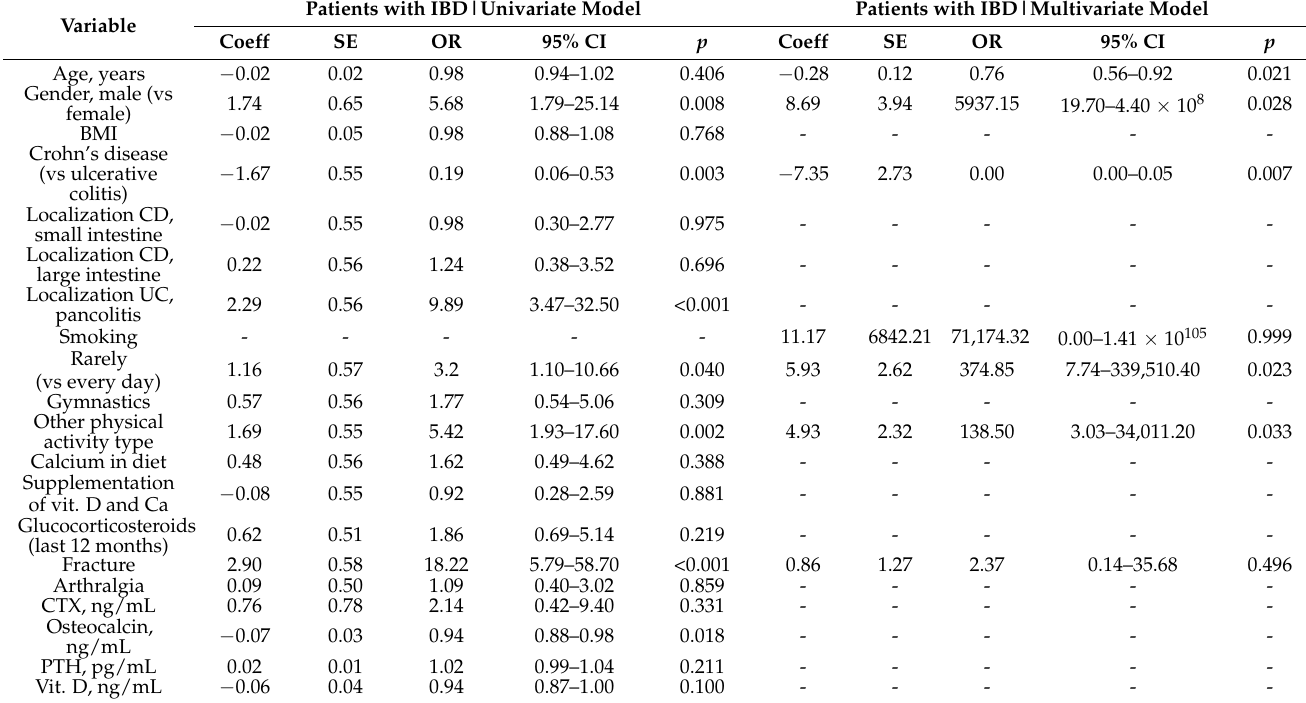
Table 3. Logistic regression model for osteoporosis in patients with